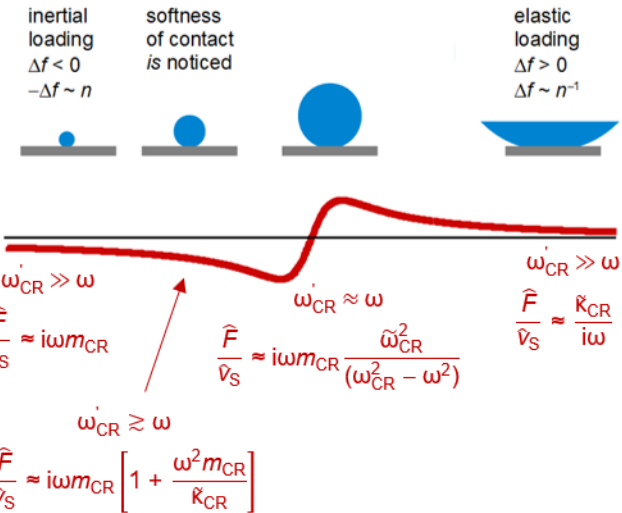
Figure 32. The frequency shift induced by a coupled resonance, following Equation (79). At low and high ω , the Sauerbrey limit and the elastic-load limit are recovered. The overtone scaling in these limits is − Δ f / n ≈ const and +Δ f · n ≈ const. In a range next to the Sauerbrey regime, the softness of the contact can be inferred from a non- trivial the overtone dependence of Δ f / n + iΔΓ/ n . Box 3 . The electromechanical analogy. Differing from electricity, mechanical impedances are additive when two elements are ar- ranged in parallel. Inverse impedances are additive, when the elements are arranged in series. These are the mechanical Kirchhoff rules. In electricity, the reverse rules apply. Cur- rent (the analog of velocity) is additive, when two resistors are placed in parallel. For dash- pots arranged in parallel, the forces (the analogs of voltage) are additive.